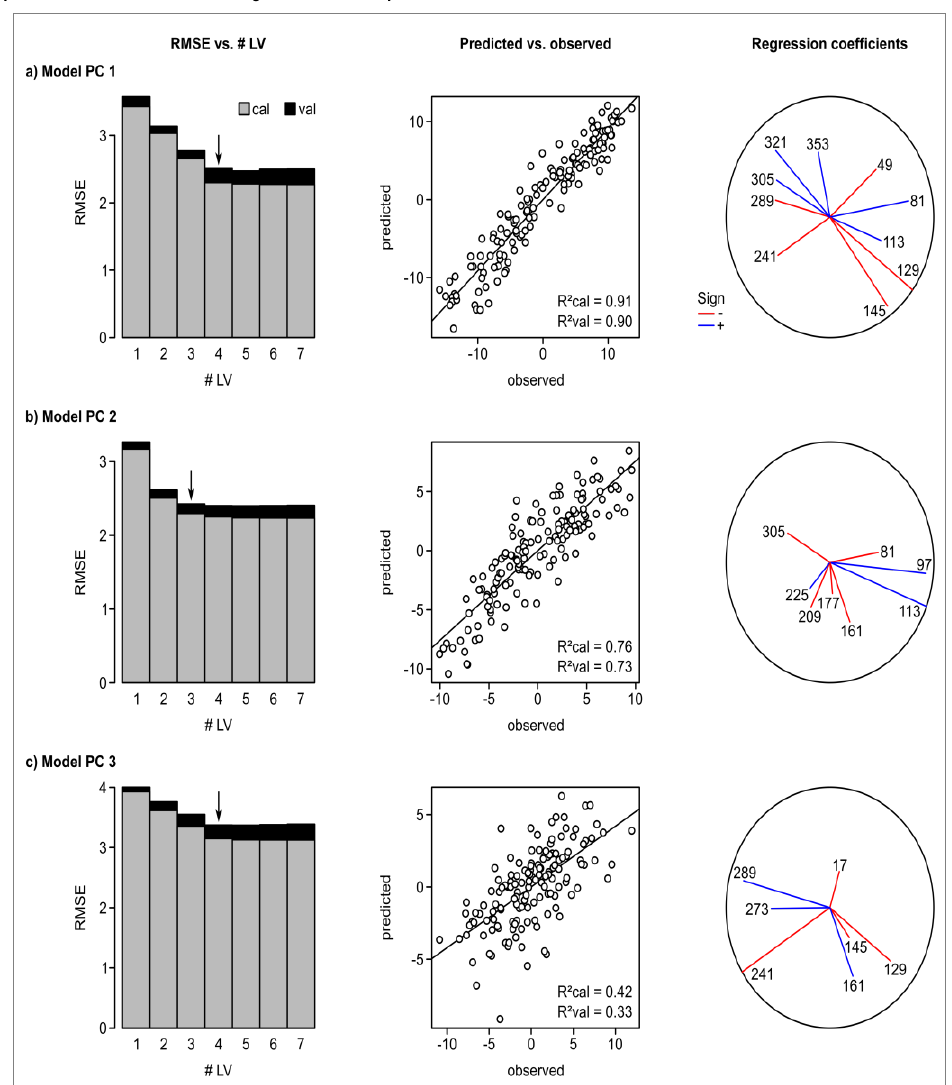
Figure 6. Results of PLS regressions between floristic gradients (PC1-3) and NDVI time series. Bar plots show the RMSE in model calibration and validation for models based on increasing numbers of LVs. Arrows in the RMSE-plots indicate the number of LVs considered in the final model. Scatterplots illustrate the relationship between actual ( i.e. , observed) PC scores and the model predictions. The influence of different dates throughout the year in the models is indicated by the regression coefficients. Numbers in these plots correspond to the Julian day of the respective NDVI time series.